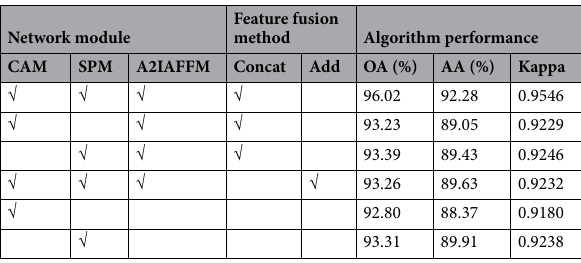
Table 5. Ablation analysis on IP dataset.